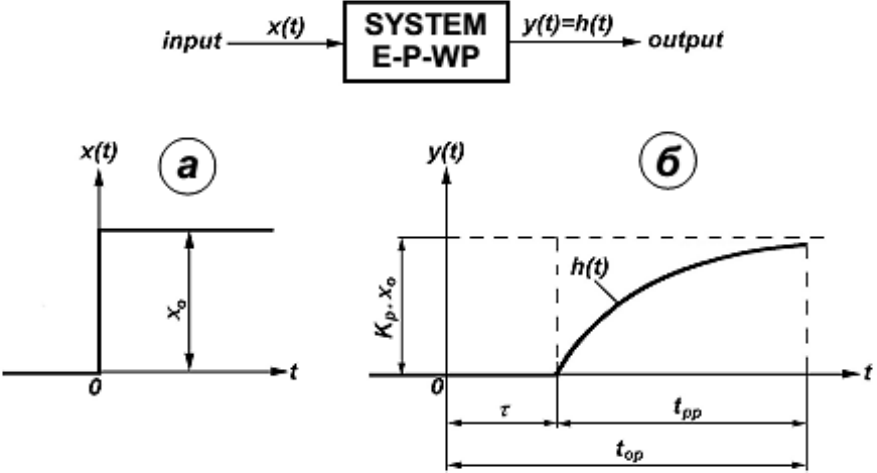
Figure 6. The response of oscillatory transporting platform during the sieving of wet earth mass due to disorder that is caused by jumping causal function (  - the delay time of the output signal relative to the input signal; t pp - length of the transition process; t op - response time of the